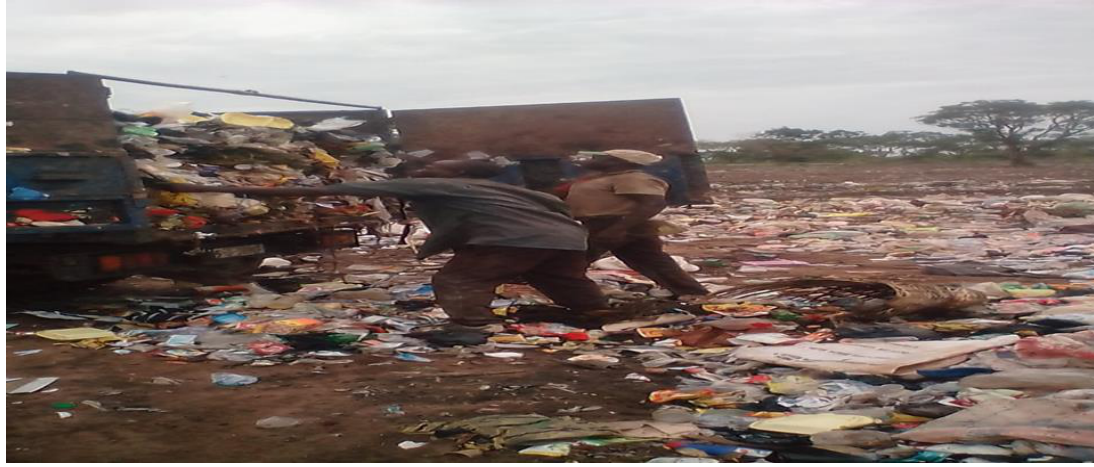
Plate 1. Cross-section of scavengers working on the